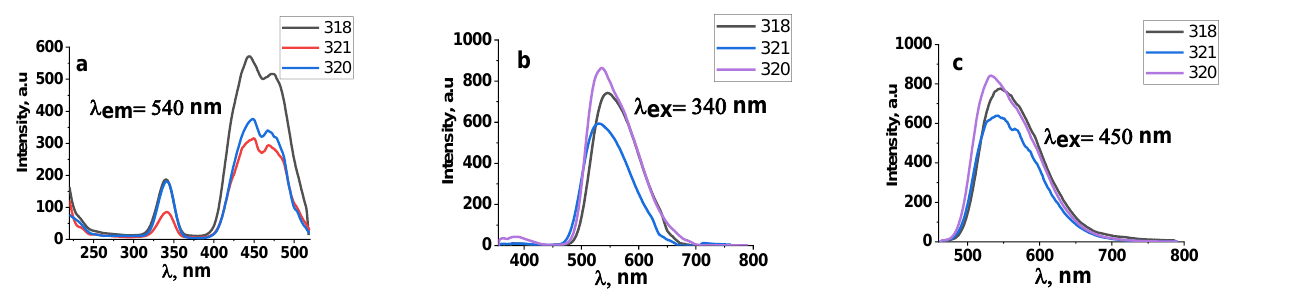
Figure 8. Excitation ( a ) and luminescence spectra ( b , c ) of ceramic samples synthesized under the exposure to an electron beam with E = 2.5 MeV and P = 8 and 10 kW/cm 2 in the “without scanning” mode.